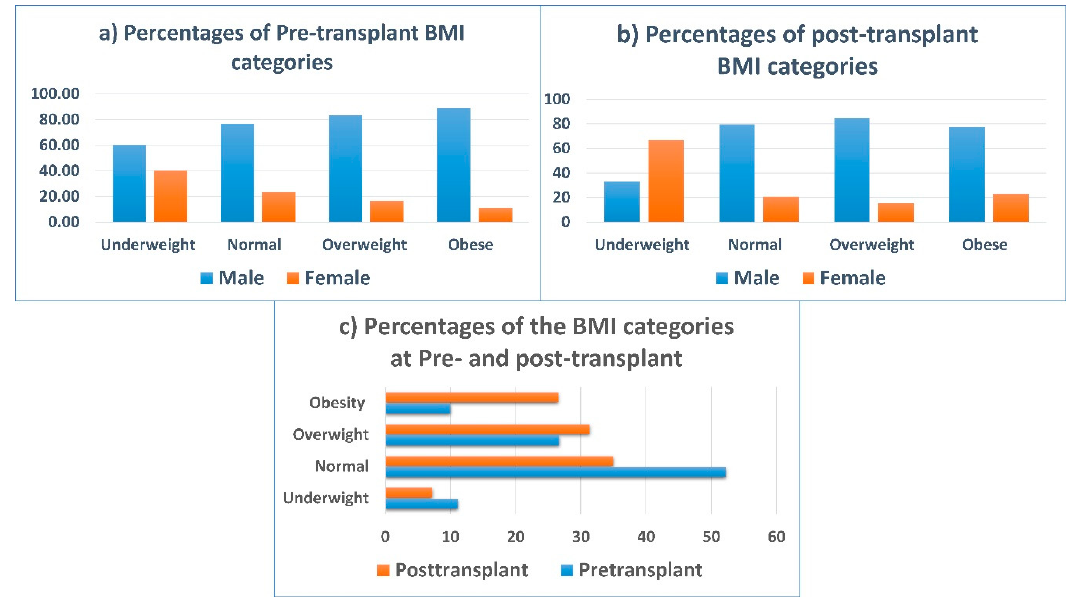
Figure 1. ( a – c ): Percentages of the changes in body mass index (BMI) classifications from pre-transplant to 1-year post-transplant according to gender.